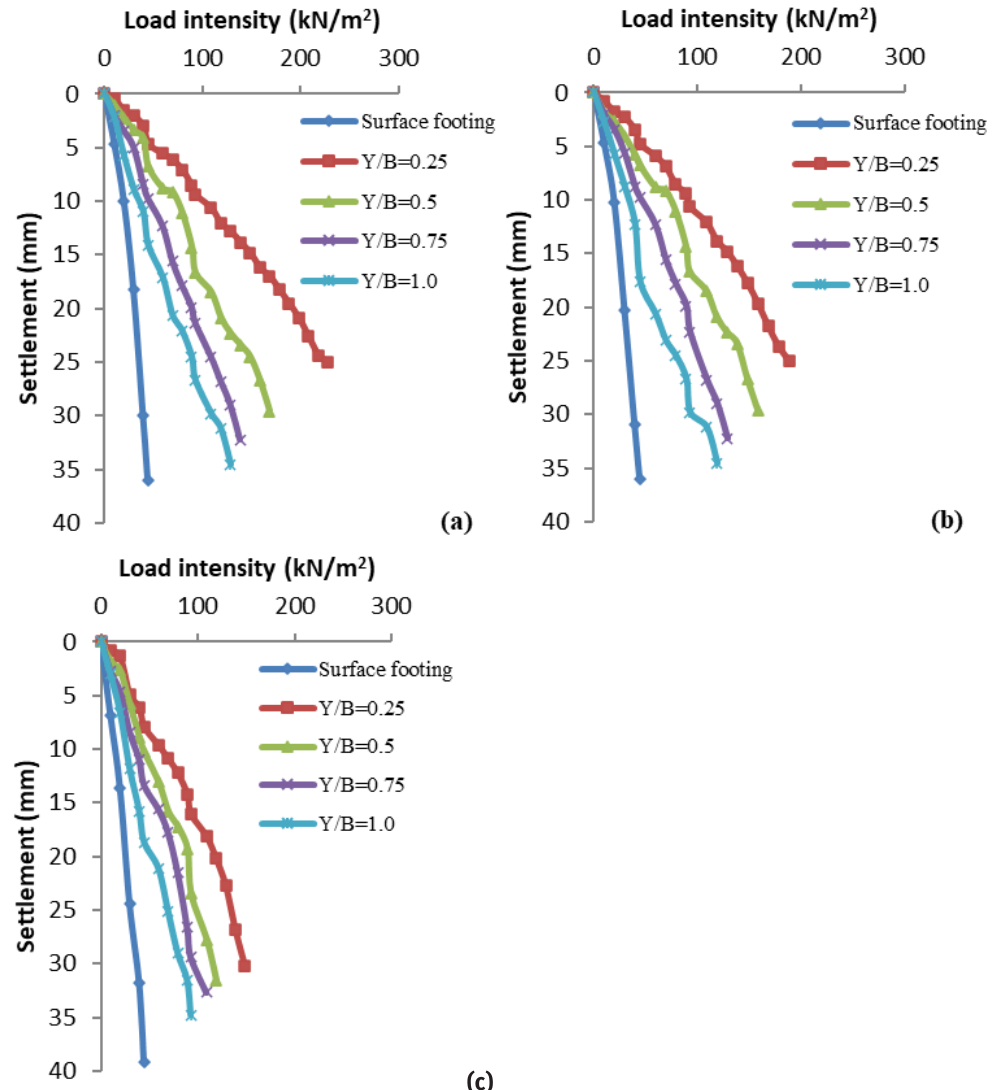
Figure 7: Load intensity-settlement behavior of footing with confiner (D/B=2.0;d/B=2.0) and reinforcement (a) 5° (b) 10° (c) 20° angle of